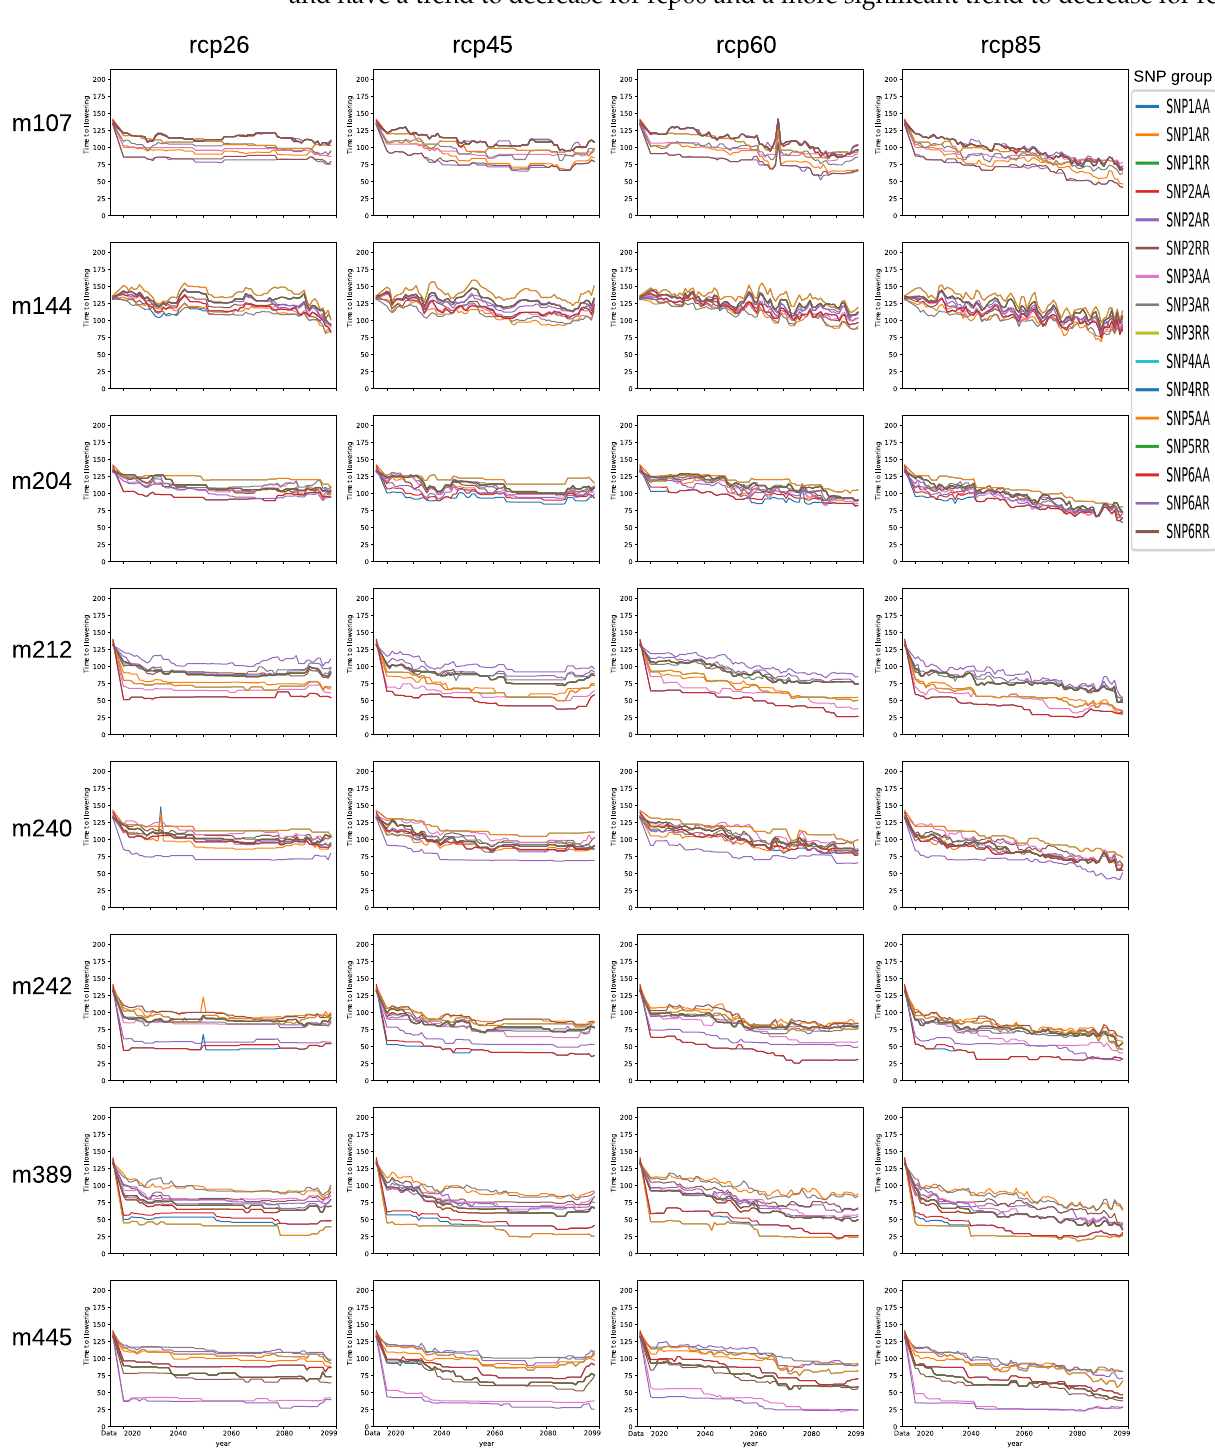
Figure 11. Forecast for time to flowering for SNP groups for years from year 2021 to 2099 in Ankara and for sowing date 339 DOY. Each column corresponds to one representative carbon dioxide concentration profile and each row corresponds to one of the ensemble model. The left-most point for each curve corresponds to the time to flowering in the data